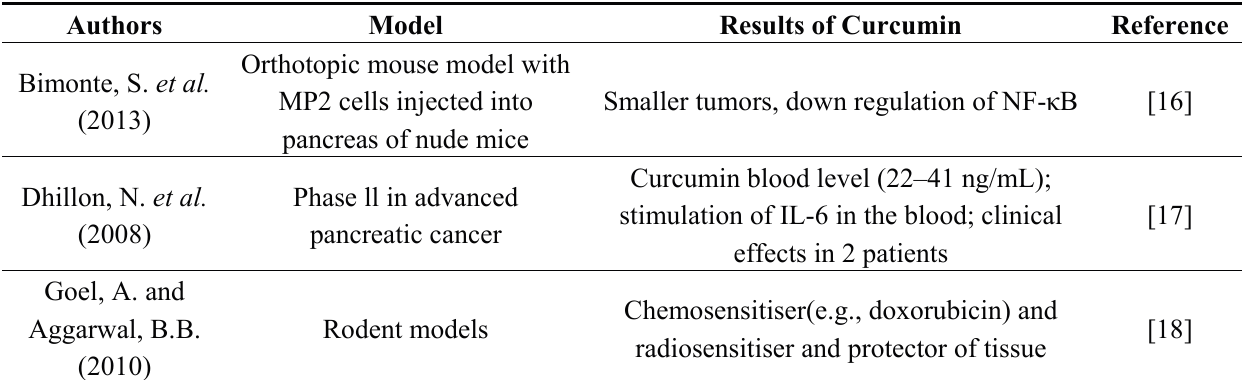
Table 1. Curcuminoid effects against pancreatic cancer in rodent models and clinical trials.